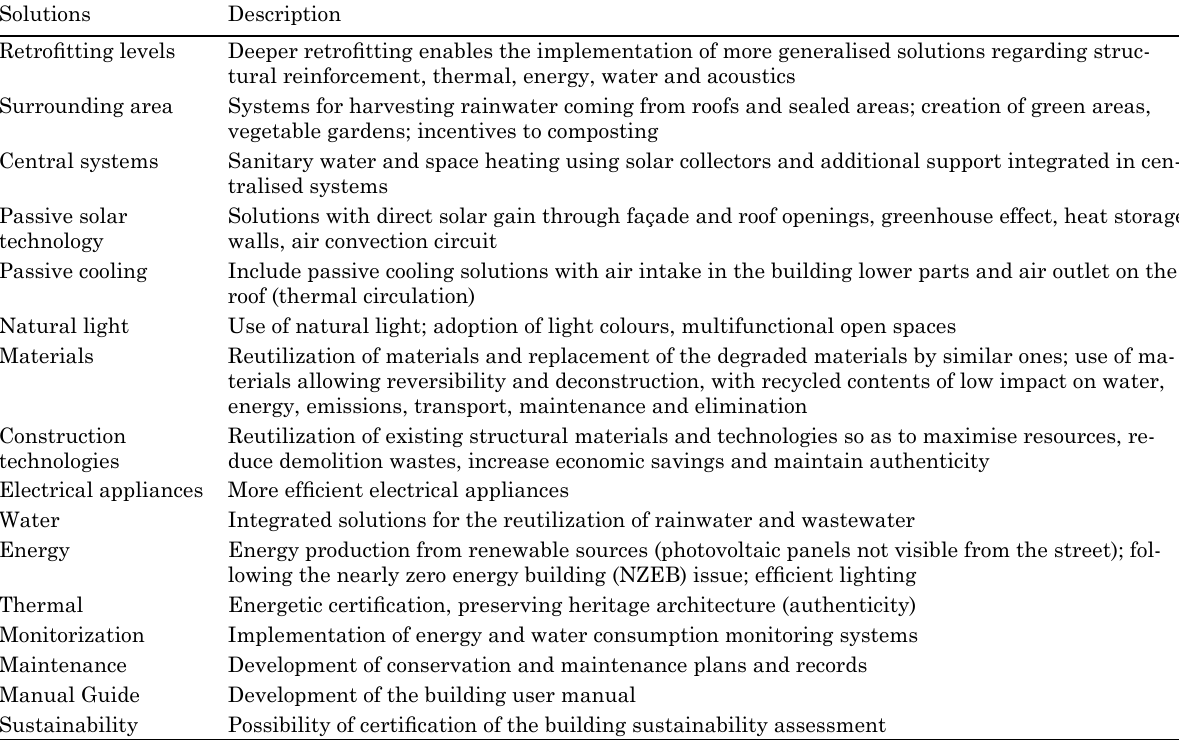
Table 1. Implementation of building sustainable solutions